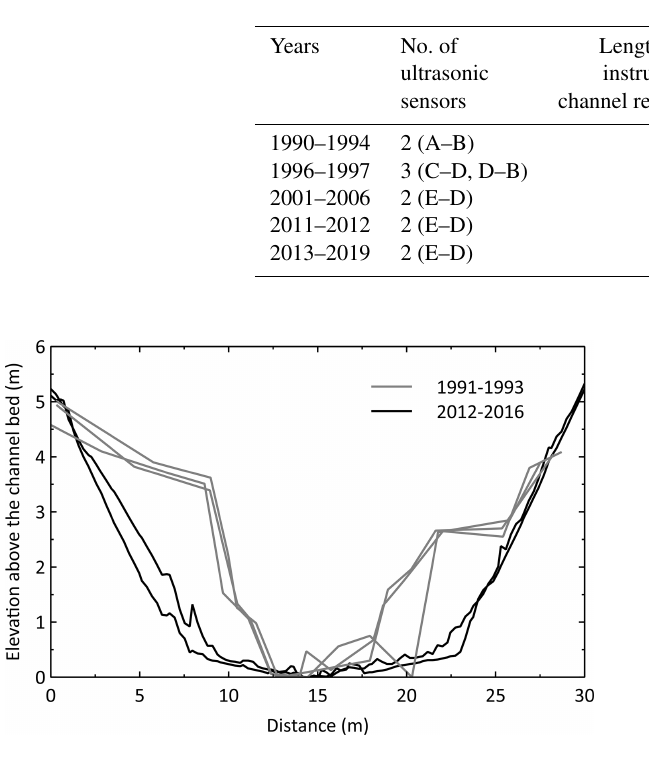
Figure 2. Cross-sections in the mid-fan area (near monitoring sites A and D, Fig. 1) before and after the implementation of control works in